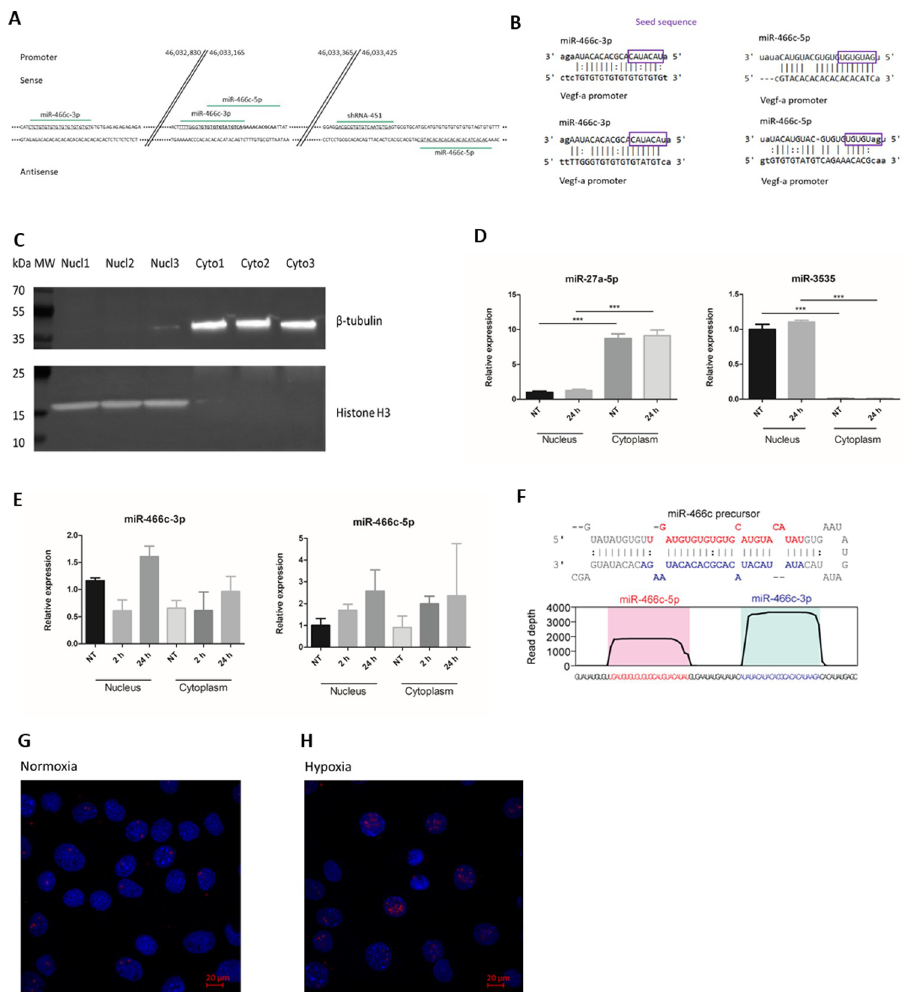
Fig 1. mmu-miR-466c is predicted to bind Vegfa gene promoter and is found in the nucleus of endothelial cells. A. Schematic figure showing the predicted targeted loci of mmu-miR-466c on Vegfa promoter. Numbers refer to locus on chromosome 17. shRNA-451 is published previously for targeting Vegfa promoter and upregulating its expression [18]. miR-466c targets were predicted using RegRNA 2.0. B. Sequence alignment showing miR-466c binding to promoter transcripts. Seed sequence of miR-466c is marked with purple box. C. Mouse endothelial cells (C166 cell line) were fractionated to nuclear and cytoplasmic fractions to study the compartmentalization of miRNAs. Purity of fractions was verified with western blot against cytoplasmic and nuclear markers β -tubulin and histone H3, respectively. n = 3. D. Purity of fractions was also verified by qPCR of cytoplasmic and nuclear miRNAs miR-27a-5p and miR-3535, respectively. NT is normoxic control sample, 24h is sample treated with hypoxia for 24h. n = 3, ANOVA with Bonferroni correction was used for determining the statistical significance, data is represented as mean ± SD. E. Both miR-466c-3p and miR-466c-5p were detected from both nucleus and cytoplasm of C166 cells by RT-qPCR. miR-466c expression was increased upon hypoxia, especially miR-466c-3p was induced in the nuclear fraction of the cells. NT is normoxic control sample, 2h and 24h are samples treated with hypoxia for 2h or 24h, respectively. n = 3–4, data is represented as mean ± SD. F. miR-466c precursor structure, from which both miR-466c- 5p and miR-466c-3p are processed. miRBase graph shows how deep sequencing reads of the mature miRNAs are distributed and miR-466c-3p is the more abundant mature miRNA. G. miRNA-FISH for miR-466c-3p confirms the nuclear localization of the mature miRNA both in normoxia and hypoxia (24h timepoint). � P � 0.05, �� P � 0.01, ��� P �